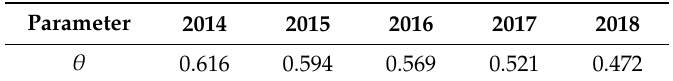
Figure 5. Aggregation coefficient distribution during 2014–2018. Figure 5 contains five graphs, which are arranged by year as: ( a ) 2014, ( b ) 2015, ( c ) 2016, ( d ) 2017, ( e ) 2018. Table 6. θ for each year.